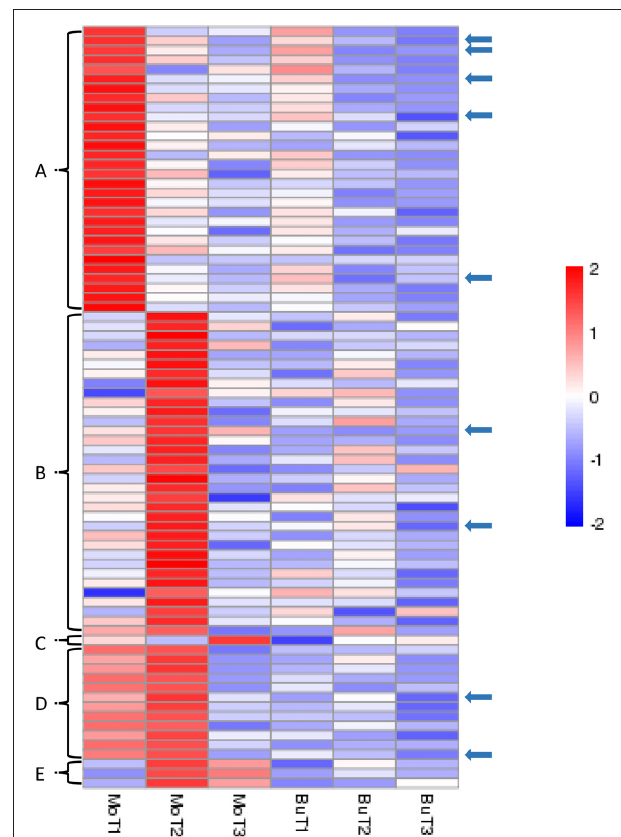
FIGURE 4 | The 80 genes with particular expression patterns in rice after treatment and low or undetected expression in rice after control treatment. Each line indicates data for one gene. Each row indicates a cluster of genes for each library. The color bar on the right represents the log 10 of the RPKM values for each gene, ranging from blue ( − 2) to red (2). (A) : 30 genes could be detected in MoT1 and could not be detected in any control libraries; (B) : 34 genes could be detected in MoT2 and could not be detected in any control libraries; (C) : 1 gene could be detected in MoT3 but could not